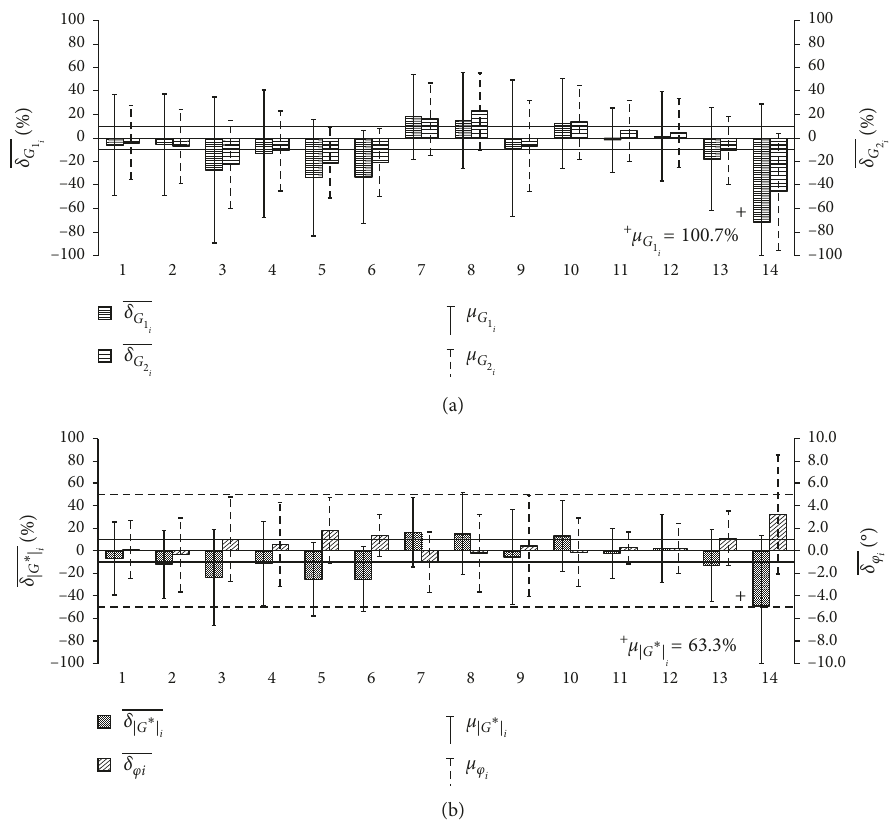
Figure 7: Histograms of global errors of 2S2P1D model fitting of all users for the bitumen (Figure 4), calculated according to equations (14)–(17): (a) relative errors for G 1 and G 2 ( δ G bars are plotted according to standard deviations μ G